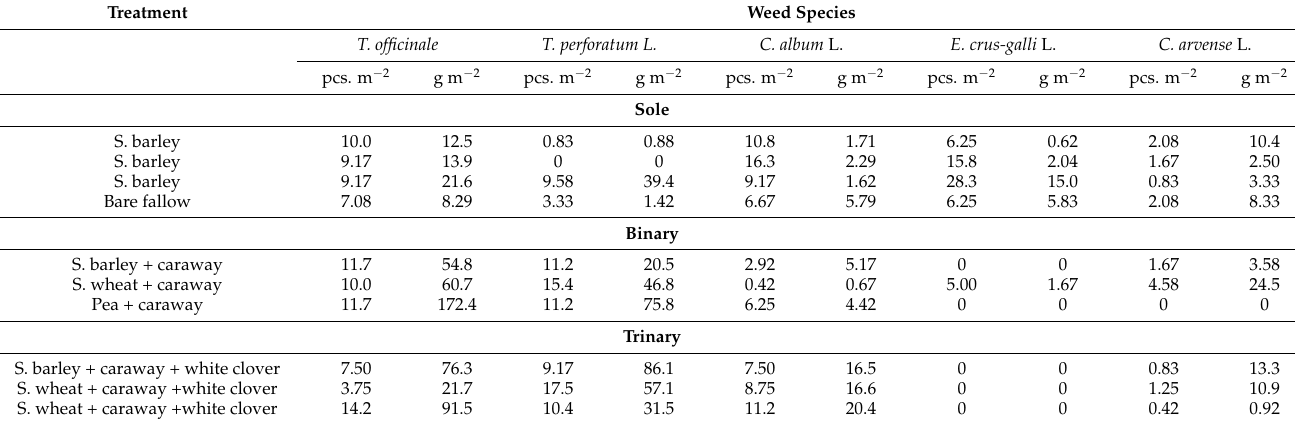
Table 4. The average number and the average biomass of dominant weed species in sole, binary, and trinary crops in 2019. Treatment